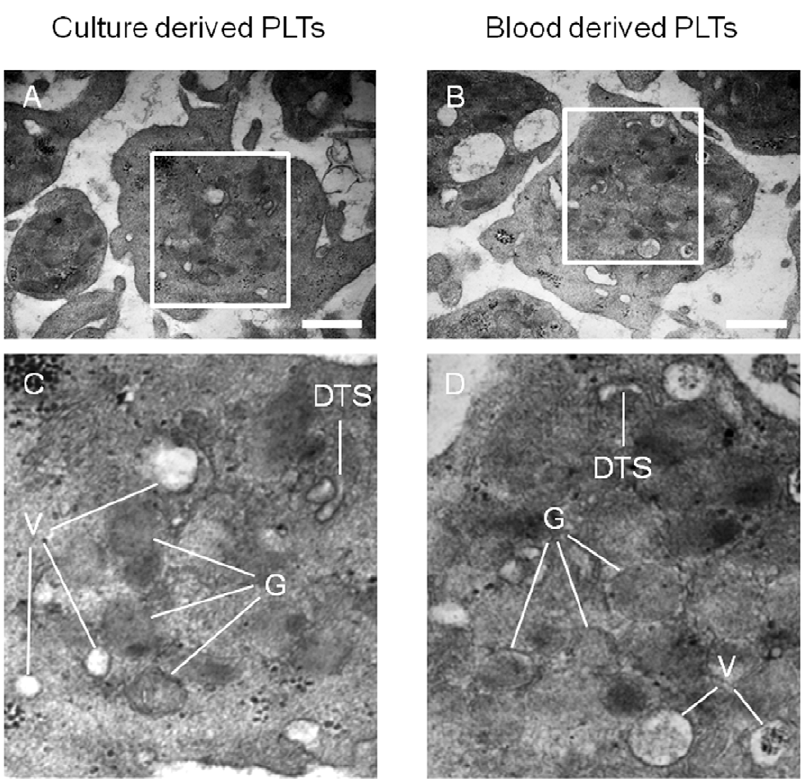
Figure 7. Ultra-structural analysis of released PLTs. Electron micrographs show that generated PLTs have typical ultra-structural morphology and cellular organelles (alpha granules, vacuoles and dense tubular system) as PLTs from peripheral blood. A: generated PLT; B: blood PLT; C: magnified view from A; D: magnified view from B; G: alpha granule; V: vacuole; DTS: dense tubular system. Scale bars: 0.5 m m in A and B.